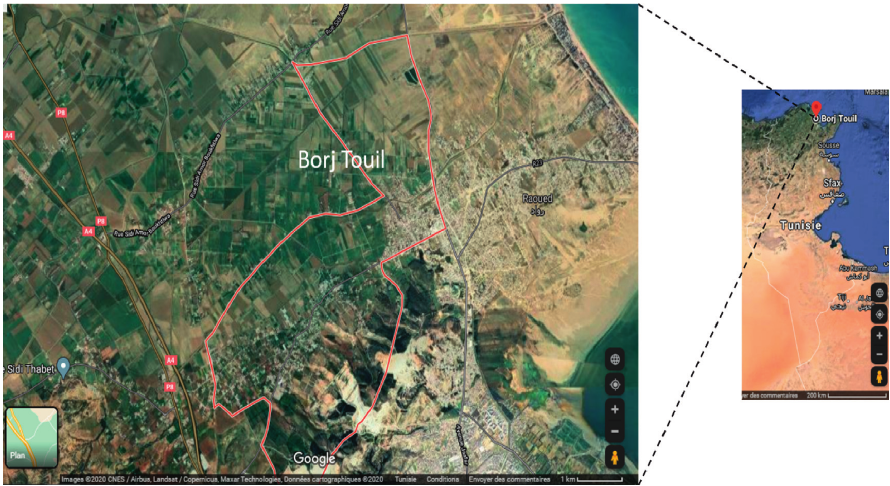
Figure 1: Localized site of Borj Touil Region (Ariana, Region 1, Tunisia, 36 ° 56 ′ 0 ″ North, 10 ° 8 ′ 38 ″